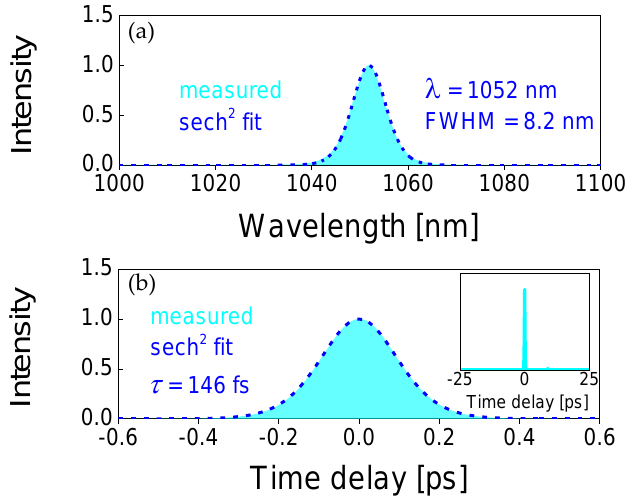
Figure 4. SESAM ML Yb:GdCB laser with T OC = 1.6%: ( a ) optical spectrum and ( b ) SHG-based intensity autocorrelation trace with a sech 2 fit. Inset : simultaneously measured long-scale SHG-based intensity autocorrelation trace for the time span of 50 ps.